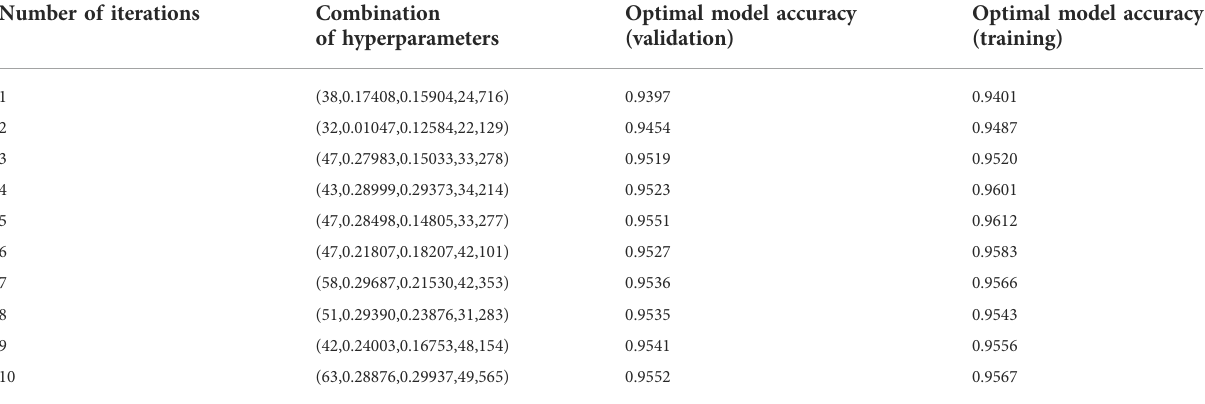
TABLE 3 Iteration process of PSO-DBN